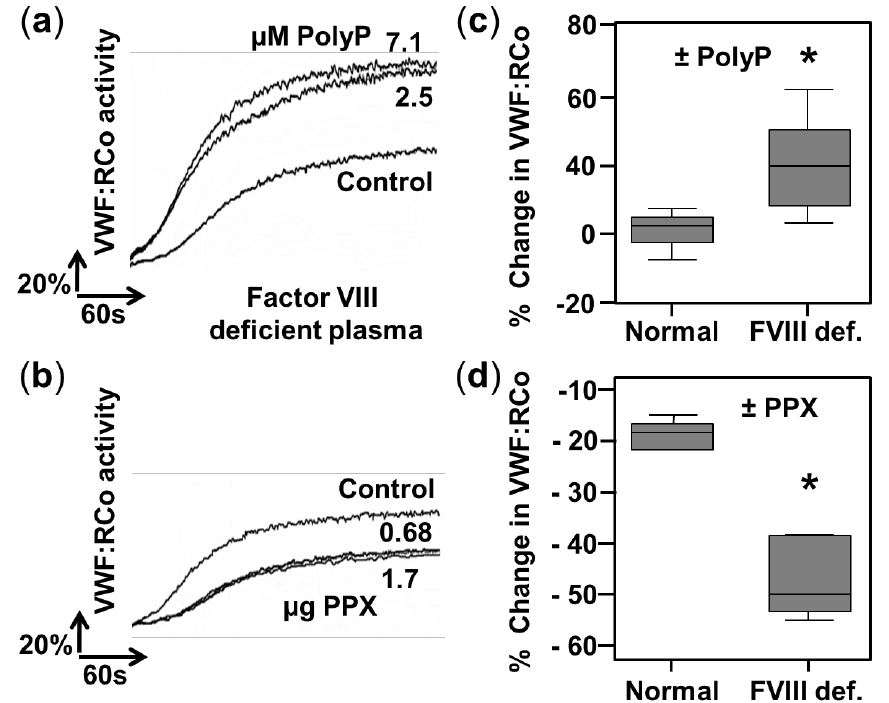
Figure 3. PolyP increases the von Willebrand Factor ristocetin cofactor activity in factor VIII-deficient plasmas. ( a , b ) Aggregation curves of fixed platelets in a ristocetin co-factor activity assay using factor VIII-deficient plasmas. Prior to the assay, 50 µ L of plasmas (diluted 1:2) were incubated in the absence (control) or in the presence of ( a ) isolated polyphosphate (polyP 65 , 2.5 µ M, and 7.1 µ M) and ( b ) recombinant yeast exopolyphosphatase (PPX, 0.68 µ g, and 1.7 µ g). Representative experiments are shown (n = 3). ( c , d ) Quantification of the differences in von Willebrand factor ristocetin co-factor activity in normal plasmas (Normal) and plasmas depleted of factor VIII (FVIII-def.) after the addition of ( c ) 2.5 µ M of isolated polyphosphate (polyP 65 ) or ( d ) 1.7 µ g of recombinant yeast exopolyphosphatase (PPX). For each sample, the change was calculated as “activity without addition of polyP or PPX” minus “activity with the addition of polyP or PPX”; therefore, positive values mean an increase above the basal activity and negative values mean a decrease. Results are presented in a box-and-whiskers plot. An asterisk indicates a statistical difference of p < 0.01, determined by Mann– Whitney test using plasmas of 3 normal individuals vs. factor VIII-depleted plasmas from three different lots. Measurements were performed using an automated aggregometer (Helena AggRAM).